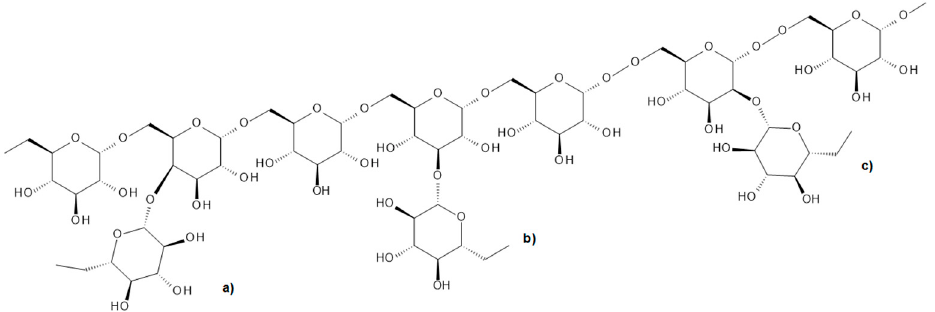
Figure 3. Structural model of dextran. Backbone formed by D -glucose units with α -(1 → 6) bonds and different branching bonds: ( a ) α -(1 → 4), ( b ) α -(1 → 3), and ( c ) α -(1 → 2). Table 1. Dextrans synthesized by lactic acid bacteria (LAB) isolated from different sources.